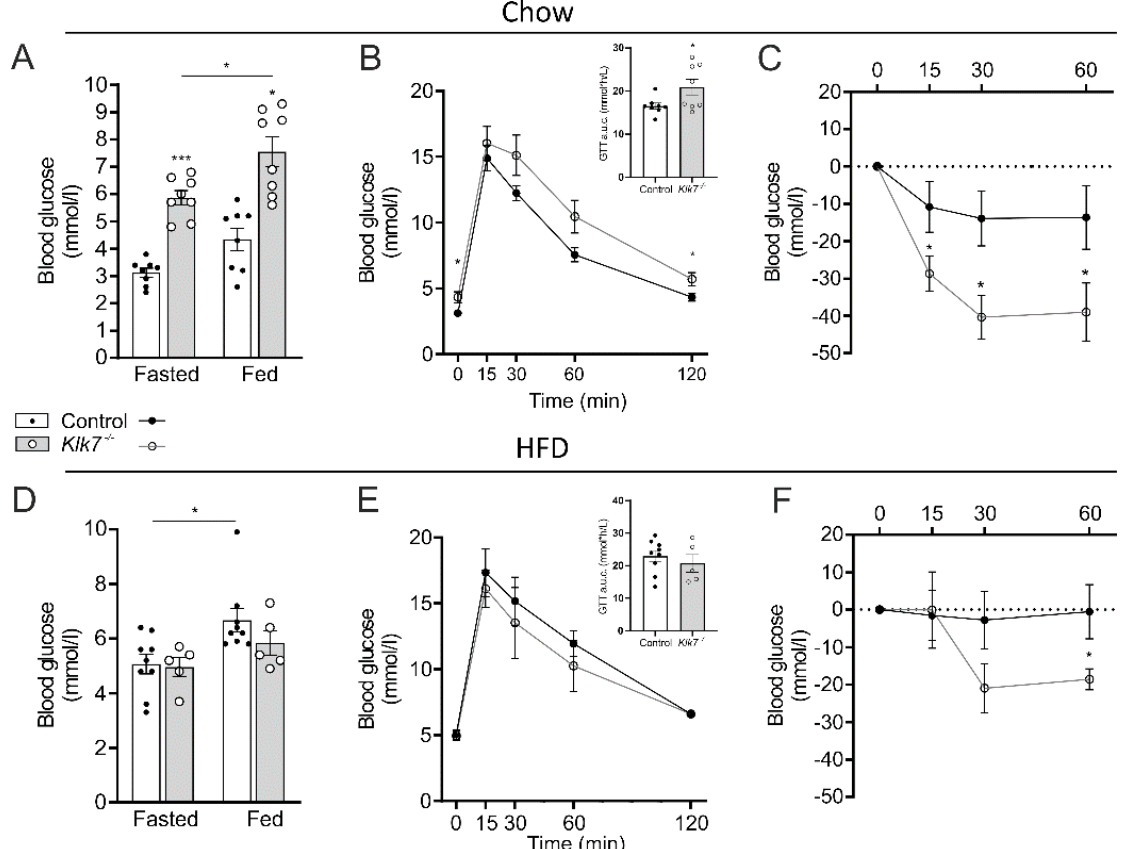
Figure 5. Glucose metabolism/homeostasis and insulin sensitivity in Klk7 − / − mice are contrastingly affected under chow and high fat diet. ( A ) Fasted and fed blood glucose levels of chow-fed Klk7 − / − mice were significantly higher than in controls ( n = 8/8, controls and Klk7 − / − ). ( B ) Glucose tolerance tests (GTT) and are under the curve (a.u.c., presented in insert) in fasted chow-fed mice reveal impaired glucose tolerance for Klk7 − / − mice (n = 8/8). ( C ) Insulin tolerance tests (ITT) in fed mice show significantly higher sensitivity to exogenous insulin for Klk7 − / − mice compared to controls ( n = 8/8). ( D ) Fasted and fed blood glucose levels of obese Klk7 − / − and control mice are not different ( n = 9/5). ( E ) GTT and a.u.c. (insert) in fasted obese mice are not affected by the genotype ( n = 9/5). ( F ) ITT in fed obese animals indicate retained insulin sensitivity in obesity for Klk7 − / − mice ( n = 9/5). Data are presented as means ± SEM; significance was tested by one-way ANOVA with correction for multiple testing (Tukey; ( A , D )), Student’s t -test (( B , E ), a.u.c data), or by two-way ANOVA and Fisher’s LSD test ( B , C , E , F ); * p < 0.05, *** p <